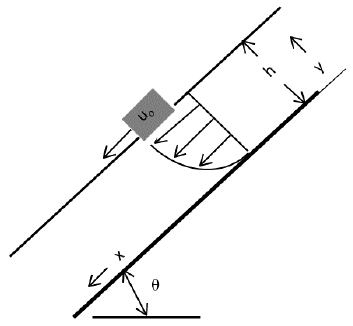
Figure 1. Diagram of undisturbed steady laminar flow down an inclined plane with parameter definitions.